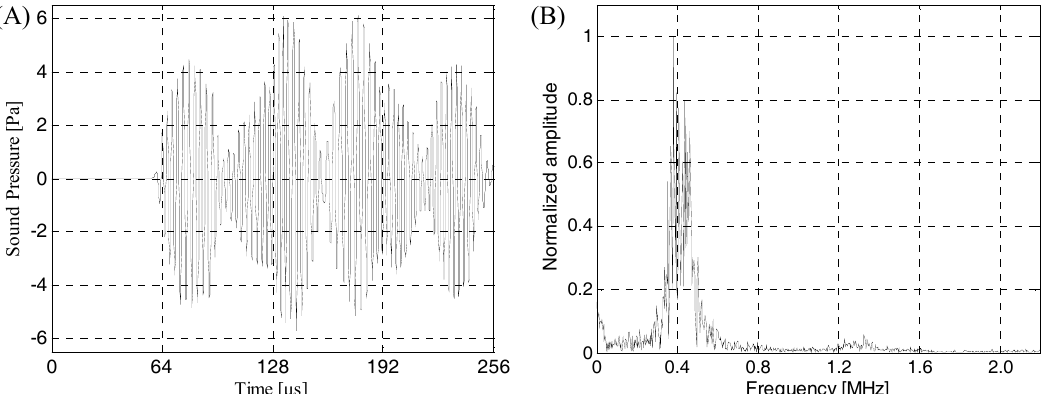
Figure 10. The time-frequency domain characteristics of the air-coupled ultrasonic signal passing through the lithium-ion battery. ( A ) Air-coupled ultrasonic time-domain signal passing through the lithium-ion battery; ( B ) the corresponding frequency spectrum.